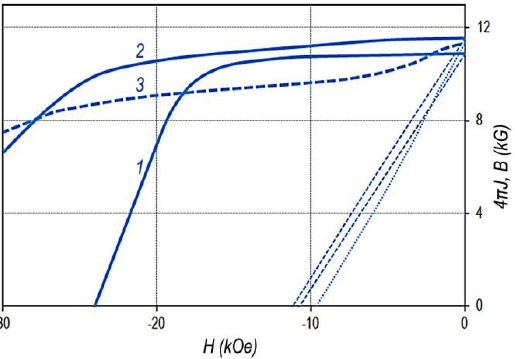
Figure 3. Magnetization reversal portions of hysteresis loops of sintered powder samples in the high-coercivity state for the Sm 0.85 Zr 0.15 (Co 0.702 Cu 0.088 Fe 0.210 ) z alloys with z = 6.0 (1); 6.4 (2); 6.7 (3).